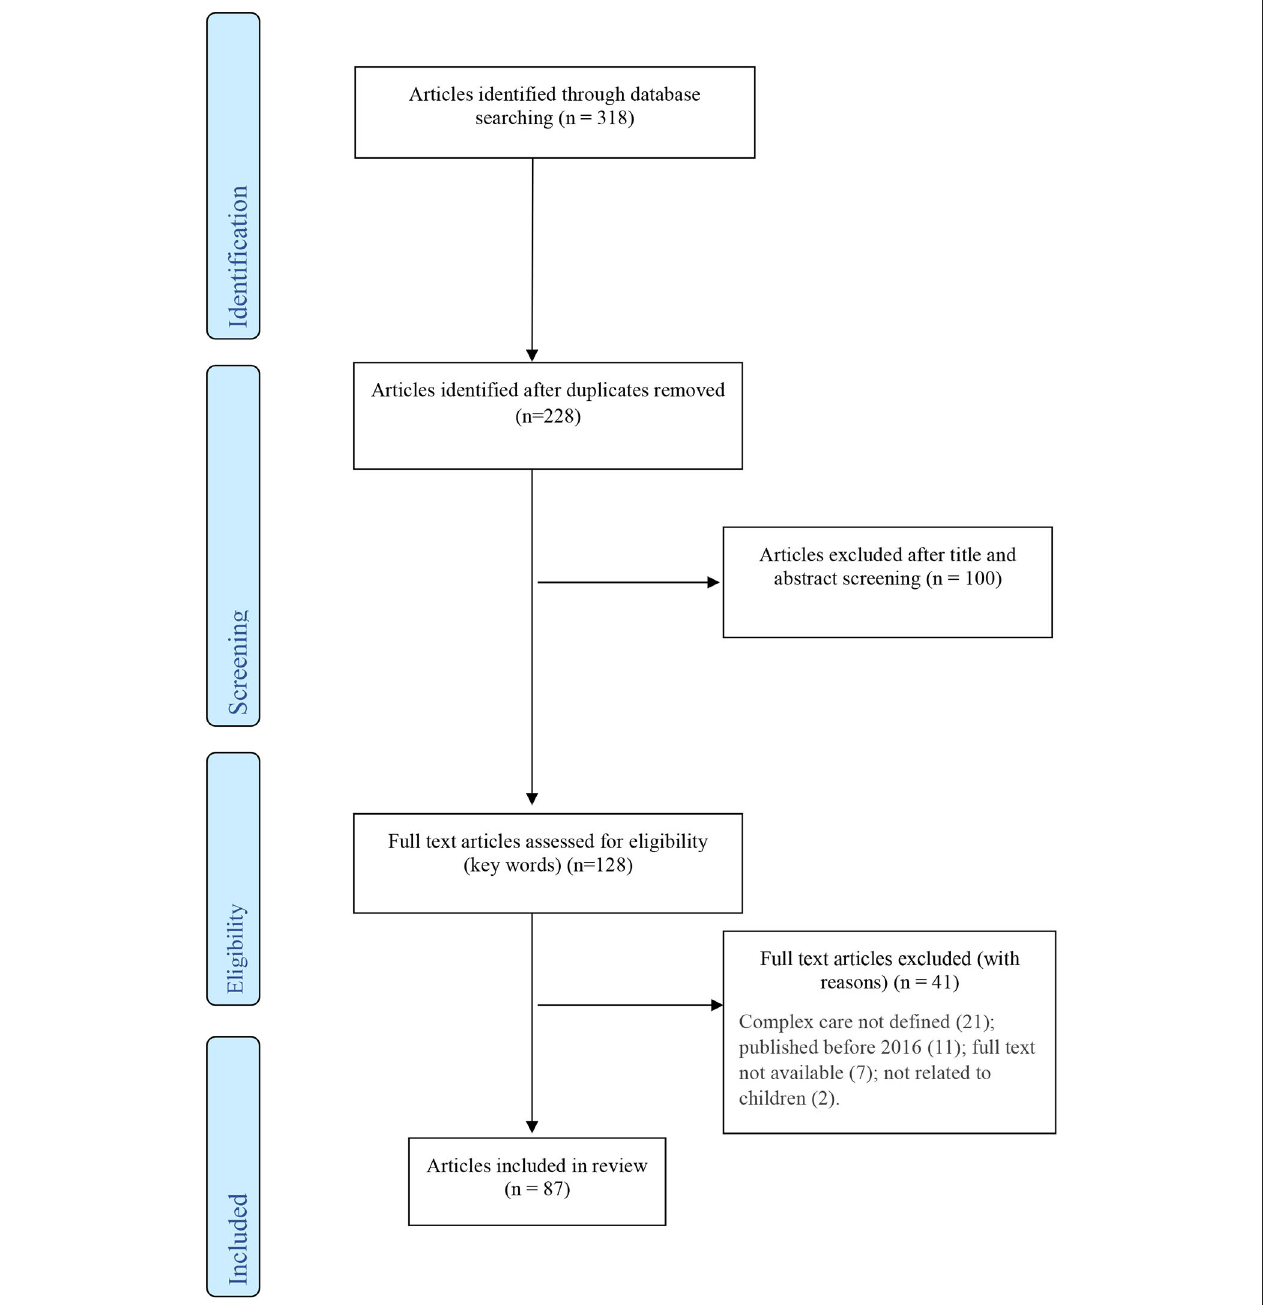
FIGURE 1 | Data search and selection